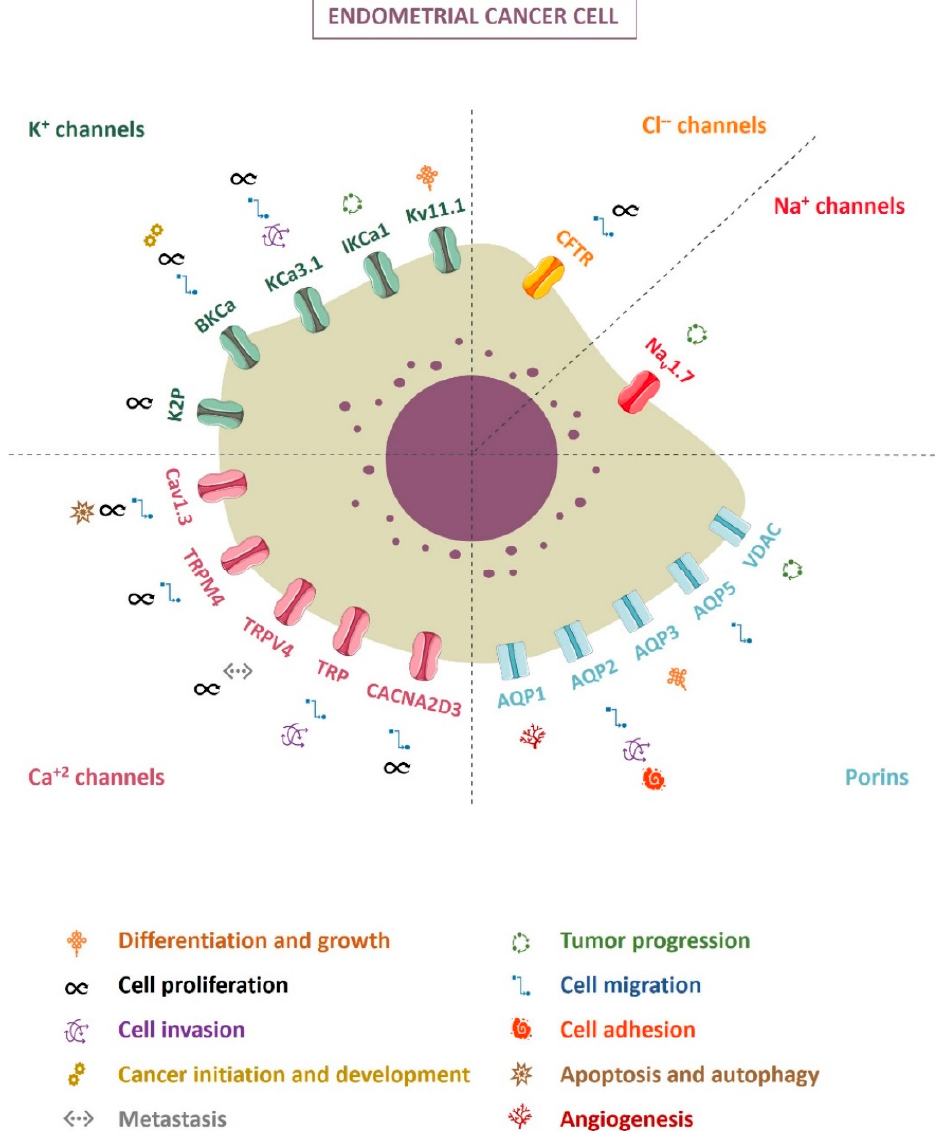
Figure 1. Ion channels and their involvement in endometrial cancer cells.